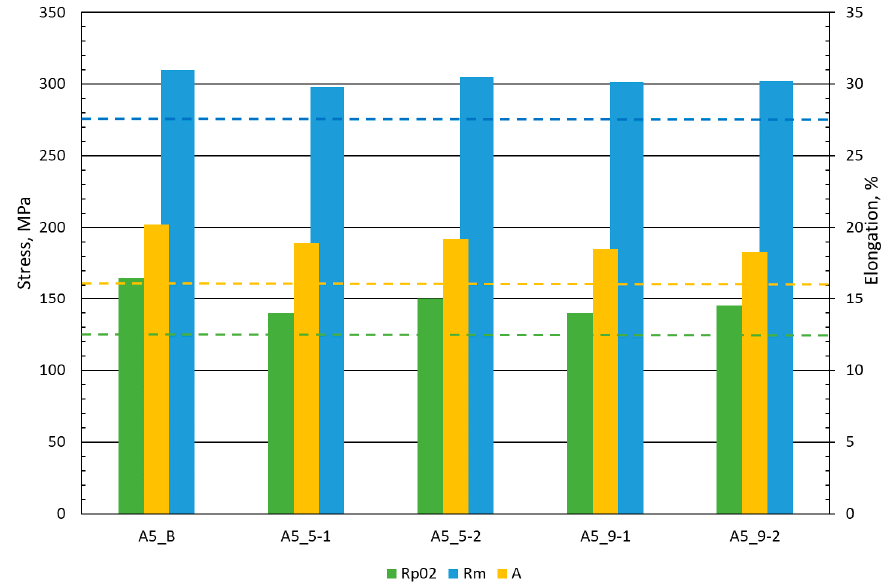
Figure 7. Tensile properties on the base of the AA 5083 H111 research performed for the base material (A5_B) and FSW joints (A5_5-1, A5_5-2, A5_9-1, and A5_9-2).